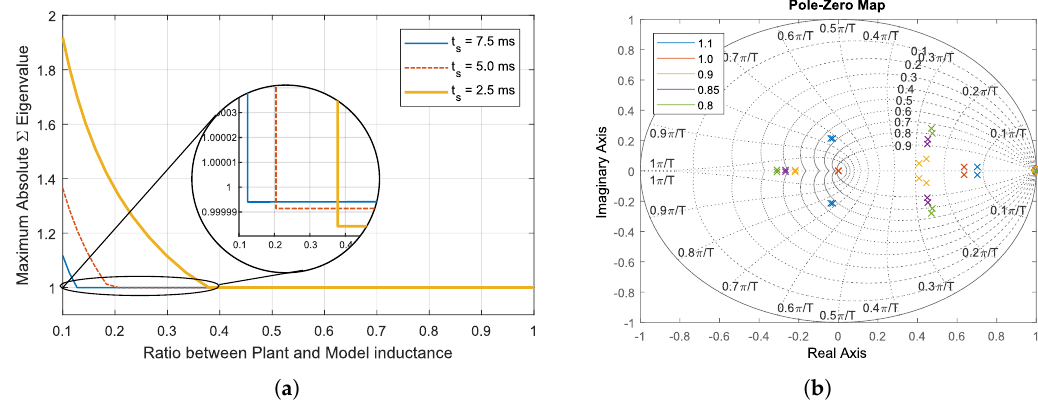
Figure 10. Stability analysis and influence of model error in the system closed-loop poles and zeros. ( a ) study of sensibility to the ratio between plant and model inductance with different controller gains ( t s is the controller settling time). The system is stable if and only if all the eigenvalues of Σ are within the unitary circle [21]; ( b ) polo-zero map of closed-loop plant with controller tuned for t s = 2.5 ms and several plant to model inductance